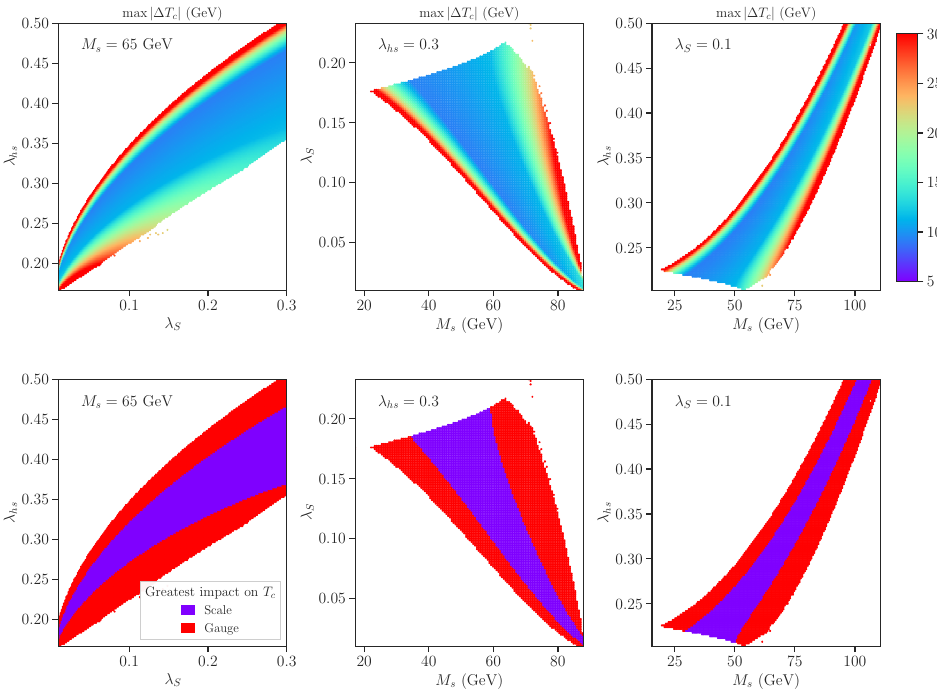
Figure 13 . Maximum change in the critical temperature from changing the gauge, renormalisation scale, renormalisation scheme or treatment of daisies. We show the magnitude (upper panels) and source (lower panels) of the maximum